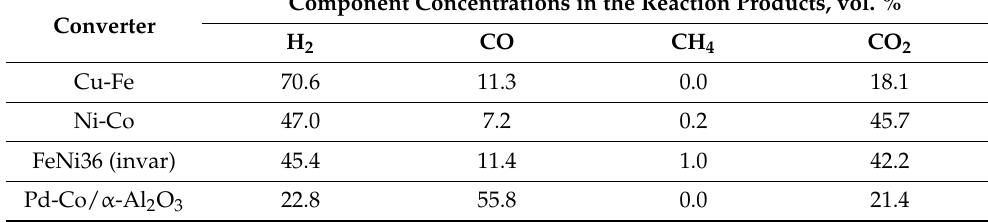
Table 2. Component concentrations in the products of water–gas shift reaction in porous catalytic converters of variable composition ( T = 650 ◦